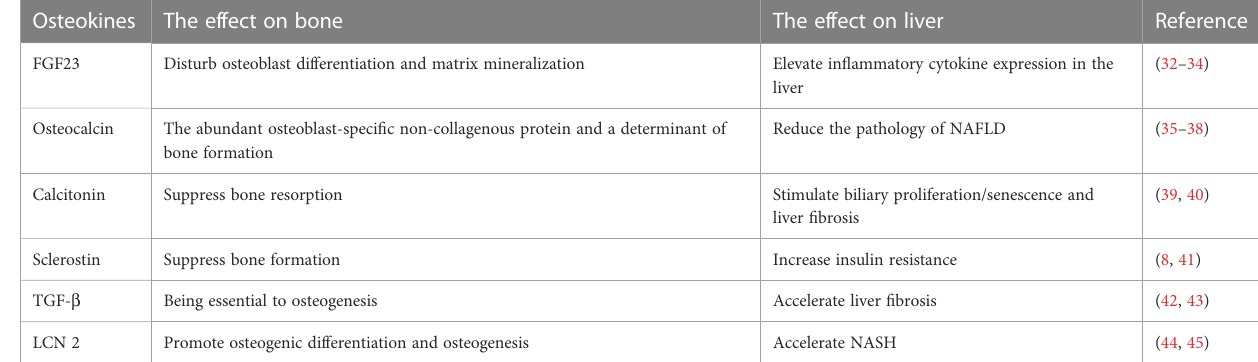
TABLE 2 Osteokines involved in liver